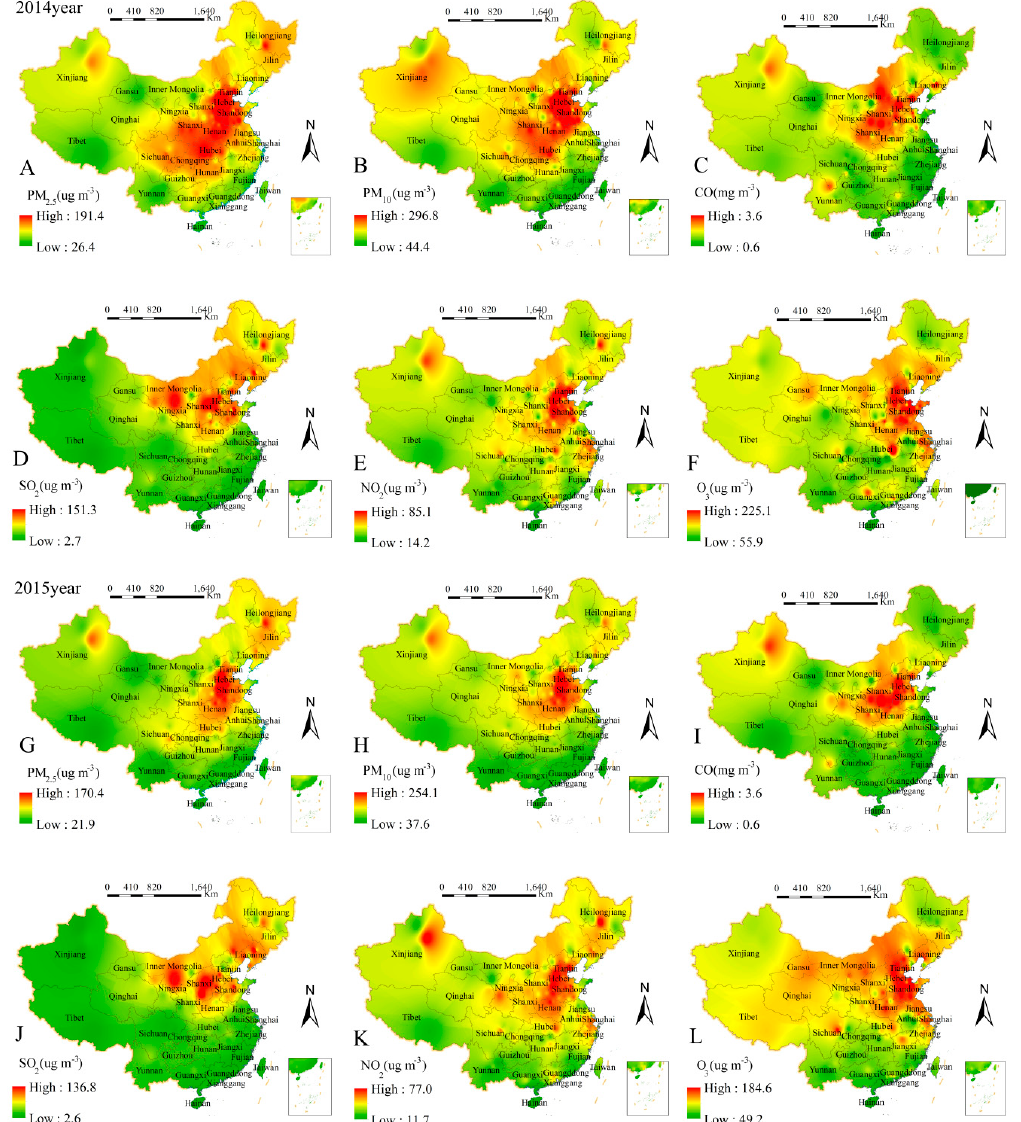
Figure 3. The spatial pattern of the mean concentrations (during January, February, November, and December) of the principal air pollutants over China (2014 and 2015). Graphs ( A – F ) represent the spatial pattern of PM 2.5 , PM 10 , CO, SO 2 , NO 2 , and O 3 in 2014, respectively; Graphs ( G – L ) represent the spatial pattern of PM 2.5 , PM 10 , CO, SO 2 , NO 2 , and O 3 in 2015, respectively.